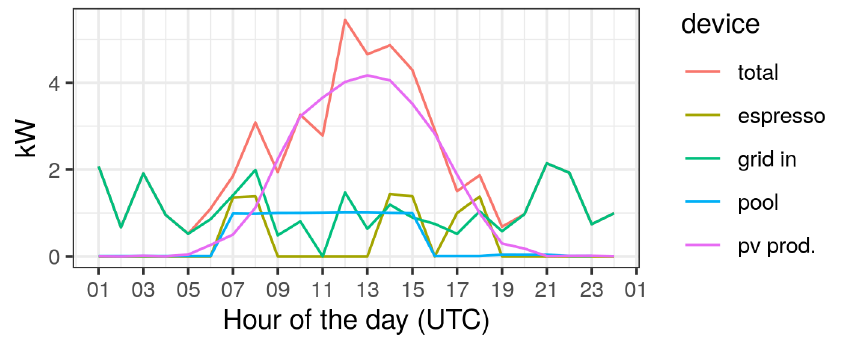
Figure 20. Power peaks with Smart Home Energy Management System.